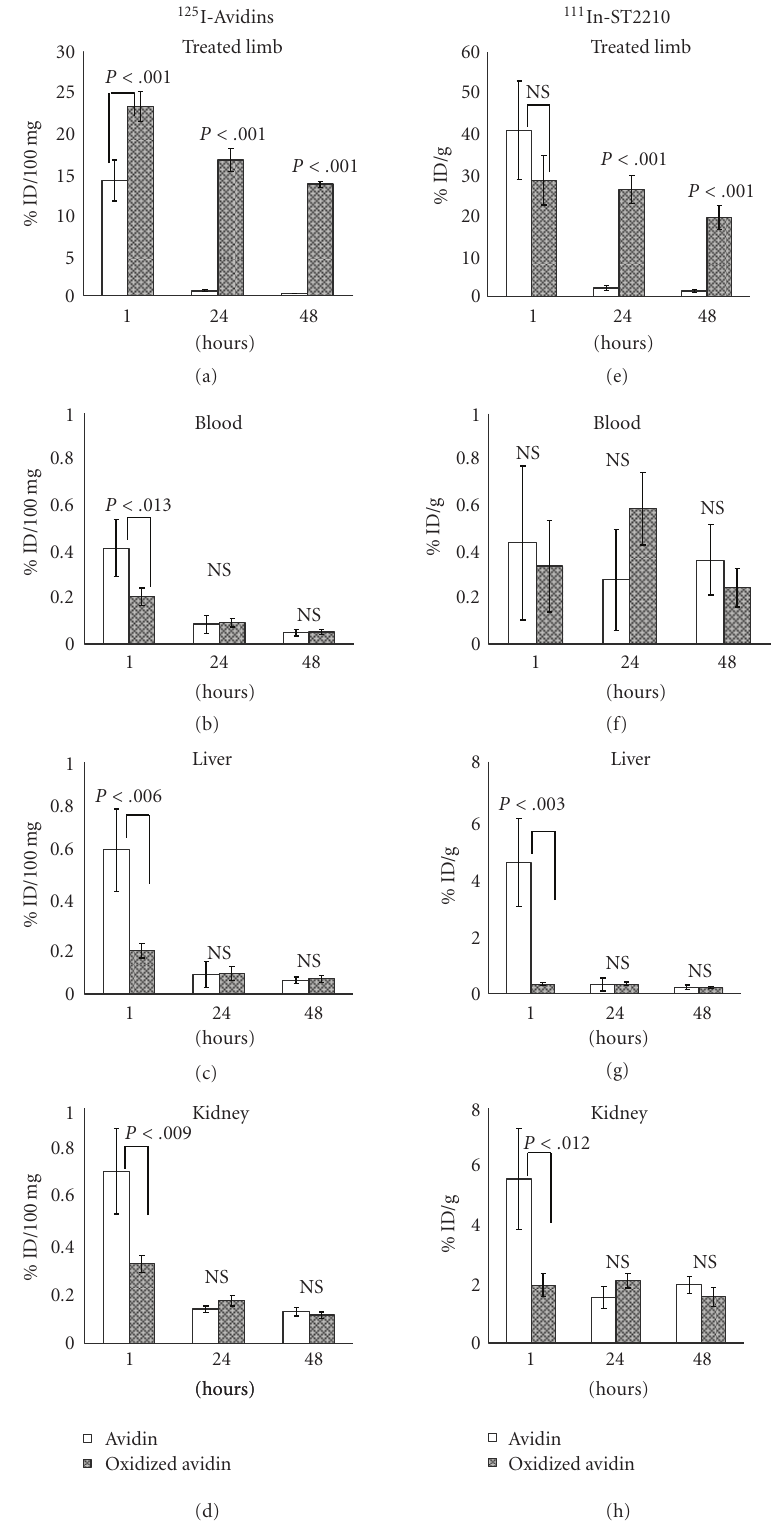
Figure 3: Oxidized avidin in vivo residence and biotin uptake. Di ff usion kinetic of 125 I-labeled avidin and oxidized avidin injected in a limb of Balb/c mice (a)–(d) and uptake of intravenously administered 111 In-ST2210 (e)–(h), after 1, 24, or 48 hours. Mice were sacrificed 1 hour after 111 In-ST2210 injection and injected sites as well as samples of non target organs were weighted and counted in a gamma-counter. Each point is the average of 5 mice. Bars represent standard deviation. Student’s t test was used for statistical analysis. NS: Not